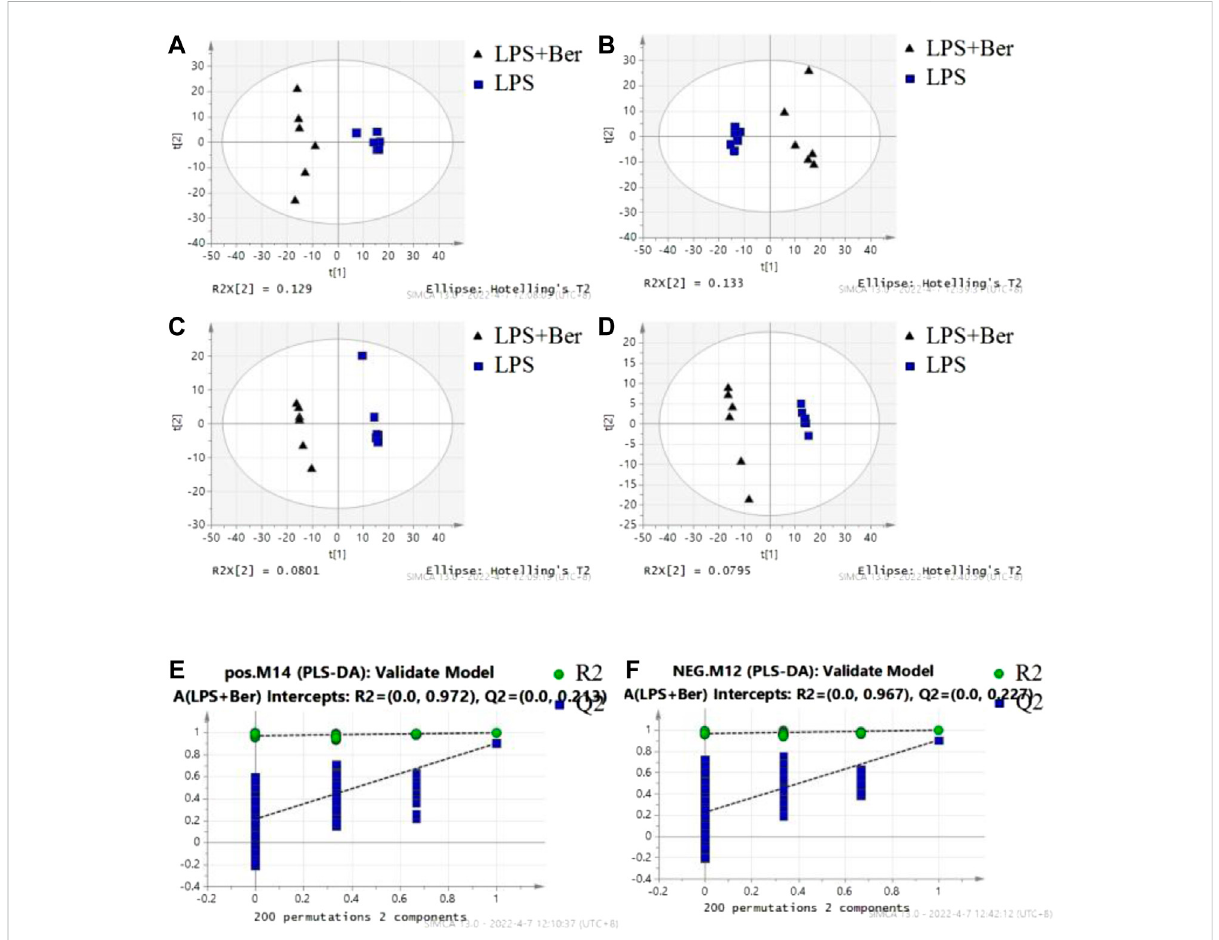
FIGURE 2 The results of multiple pattern recognition of metabolites between LPS and LPS + Ber group. (A) PCA score plot under positive ion mode. (B) PCA score plot under negative ion mode. (C) PLS-DA score plot under positive ion mode. (D) PLS-DA score plot under negative ion mode. (E,F) Permutation test of PLS-DA